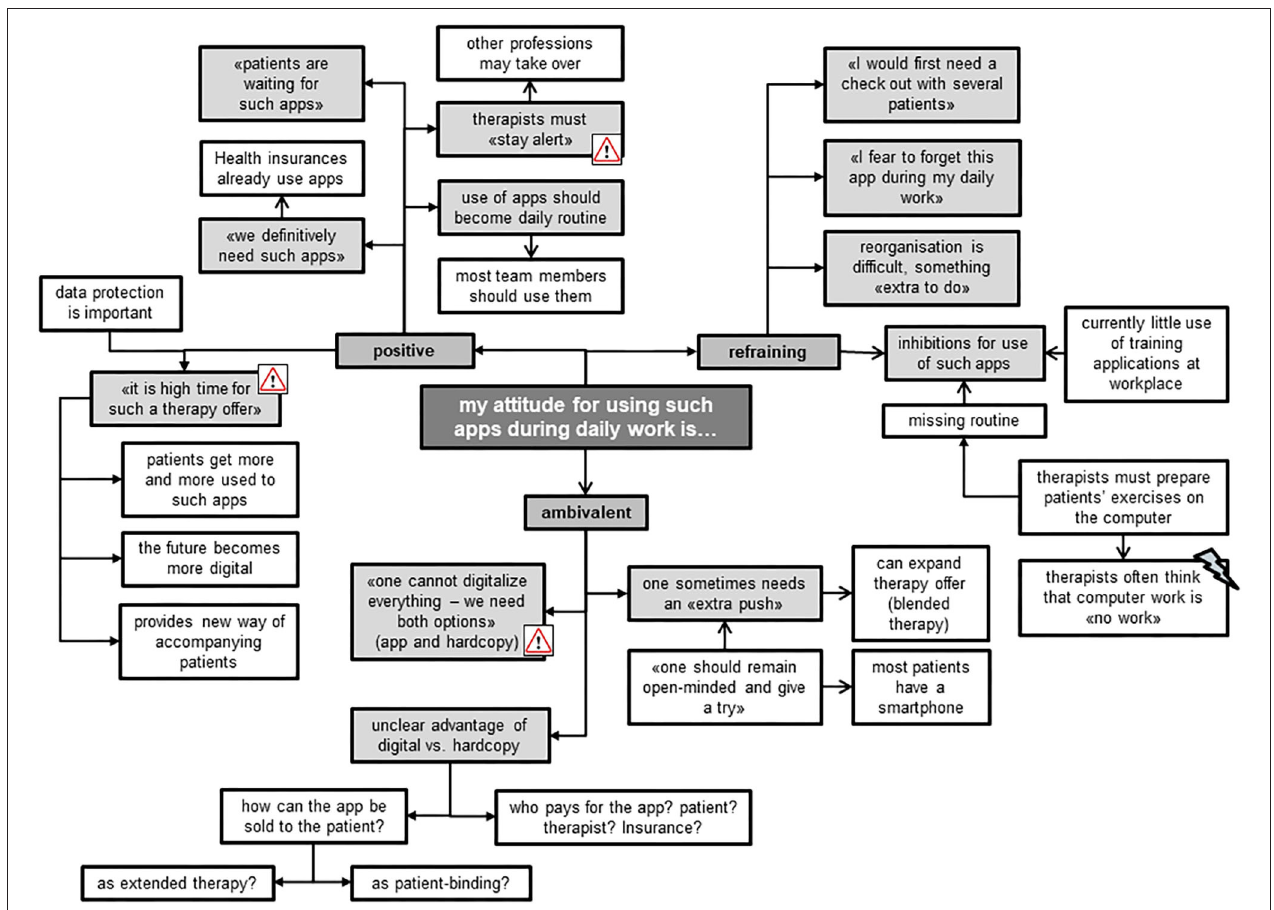
FIGURE 8 | Therapists’ attitude for using the Fit app during daily